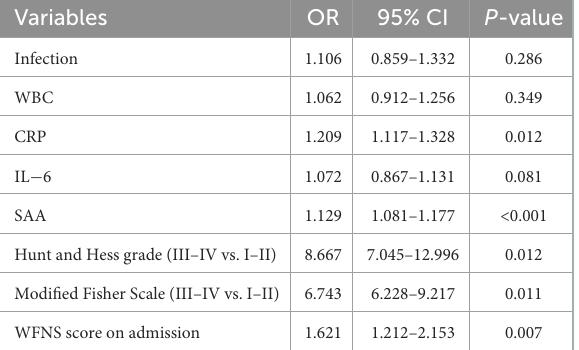
TABLE 4 Univariate logistic regression analysis of 3-month poor outcome after